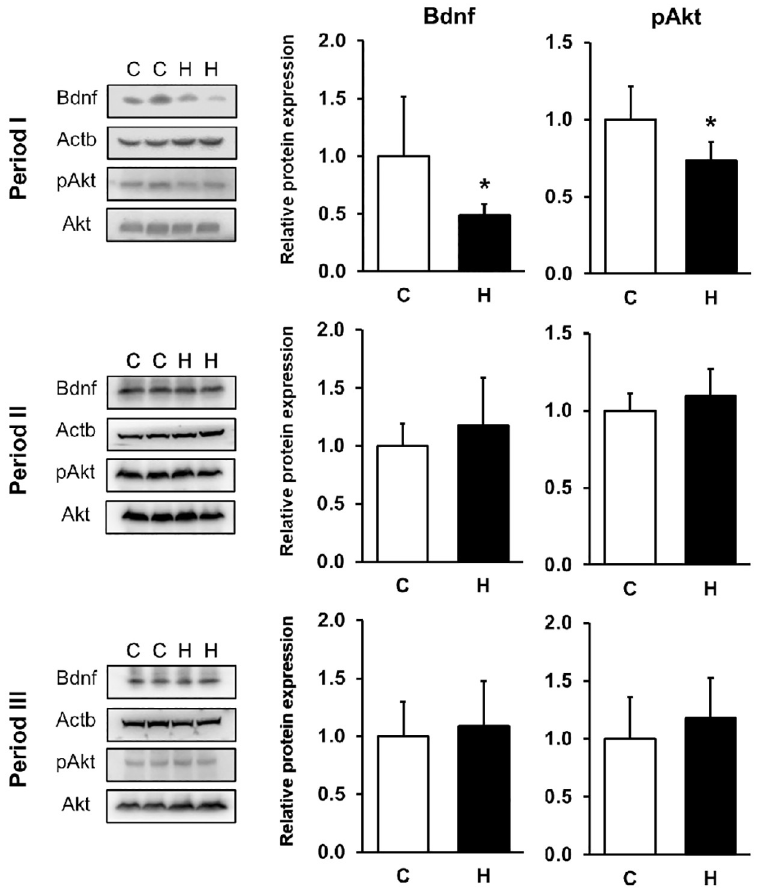
Fig 3. Hippocampal Bdnf and pAkt protein expression. The results are expressed as the ratio of relative intensity of protein expression levels to Actb or Akt. Hippocampal Bdnf and pAkt protein levels were decreased in the Period I with HFCS. Period I: C, n = 5; H, n = 6 (Bdnf), C and H, n = 6 (pAkt), Period II: C and H, n = 8 (Bdnf), C and H, n = 8 (pAkt), Period III: C and H, n = 7 (Bdnf), C and H, n = 6 (pAkt). C, Control group; H, HFCS group; data are presented as mean ± SD. � p <